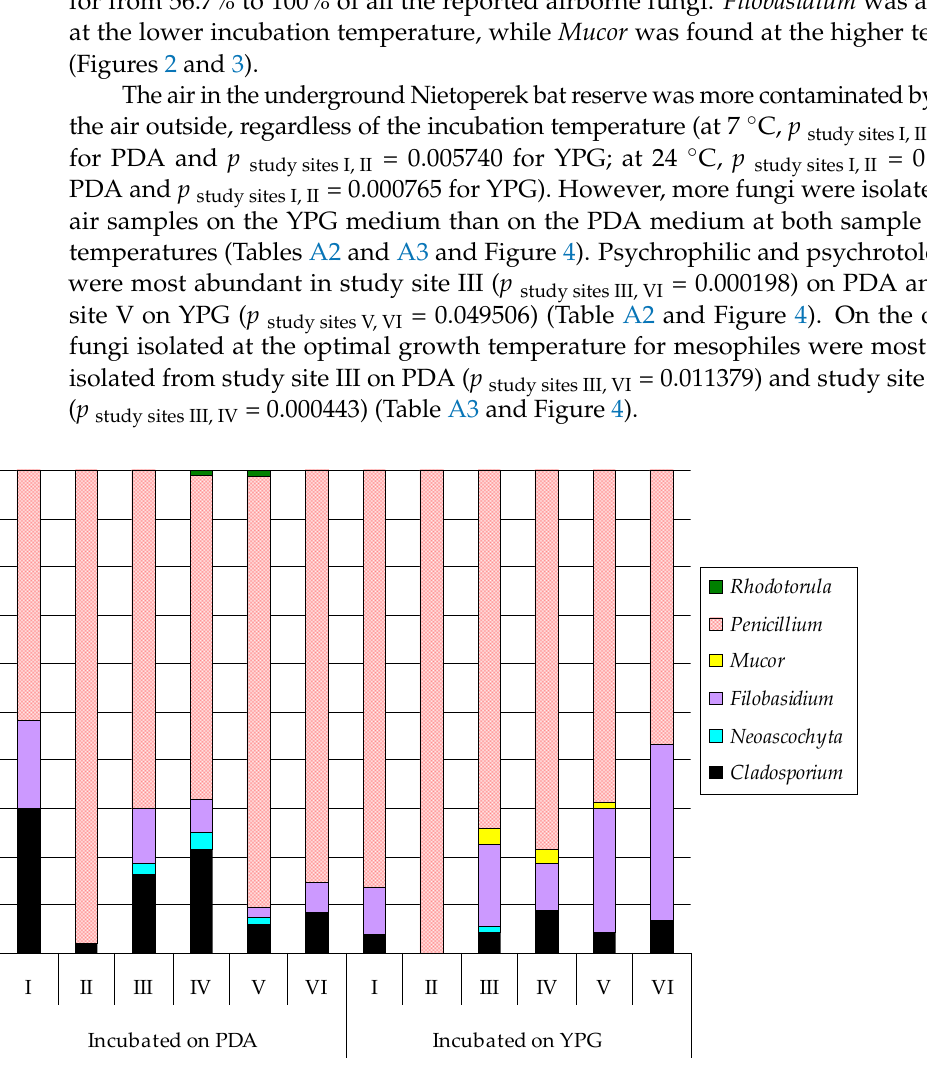
Figure 2. Percentage of each airborne fungal genus contributing to the total fungi cultured at 7 ± 0.5 °C from the underground hibernation Nietoperek bat reserve. Study site number I was outside the underground reserve and locations from II to VI inside it. The air sampler was positioned 1.5 m above the level of the floor at study site numbers from I to III and at a distance of 0.7–1 m from clusters of M. myotis in locations from IV to VI.